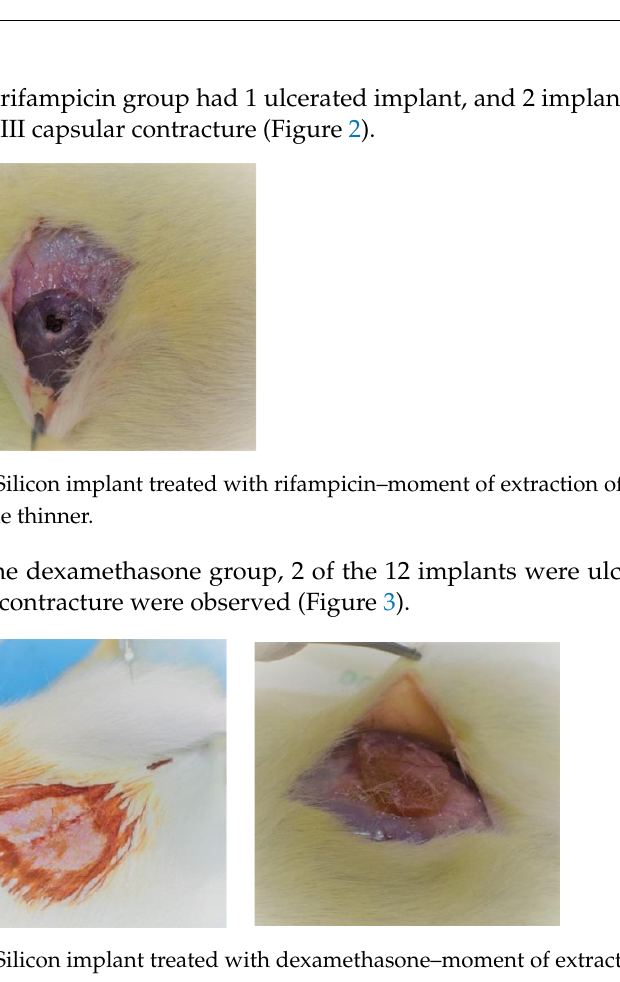
Figure 1. Silicon implant non treated – moment of extraction of the implant with the view of the remaining thick capsule.